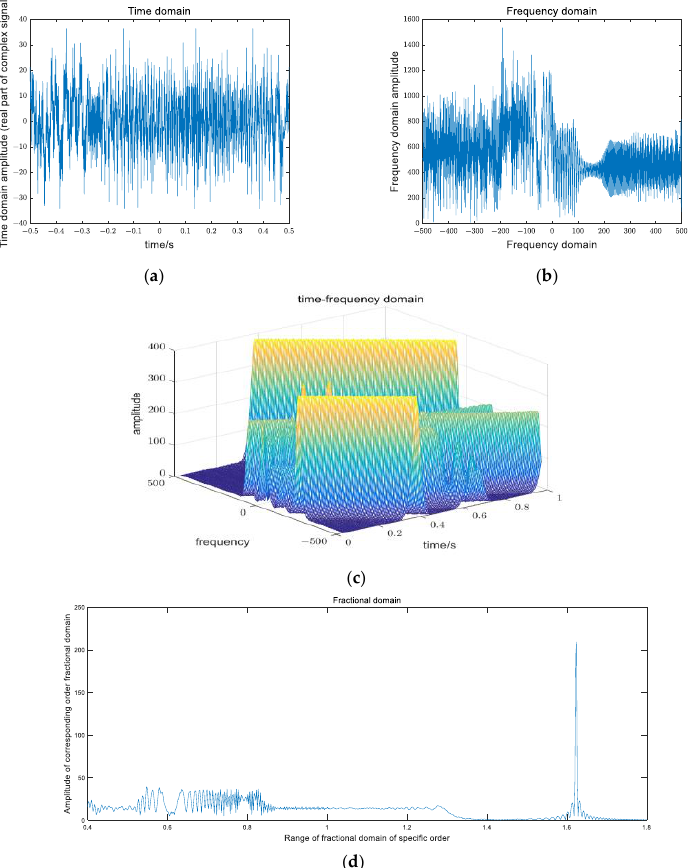
Figure 8. Comparison of different domains of mixed signals in UBSS system. ( a ) time domain; ( b ) frequency domain; ( c ) time−frequency domain; ( d ) fractional domain under optimal transformation order p = - 0.5194.